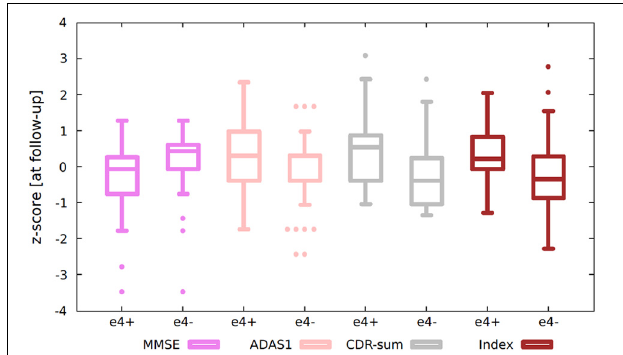
FIGURE 7 | Box-plots showing stratification by APOE status of (standardized) MCI’s index and cognitive scores. Standardized values were calculated by computing z -scores from average data. Average data = (data at baseline + data at 1-year)/2. e4 + , APOE e4 carrier; e4 − , APOE e4 non-carrier; MCI, mild cognitive impairment; MMSE, Mini Mental State Examination; CDR-sum, clinical dementia rating sum of boxes; ADAS1, Alzheimer Disease assessment